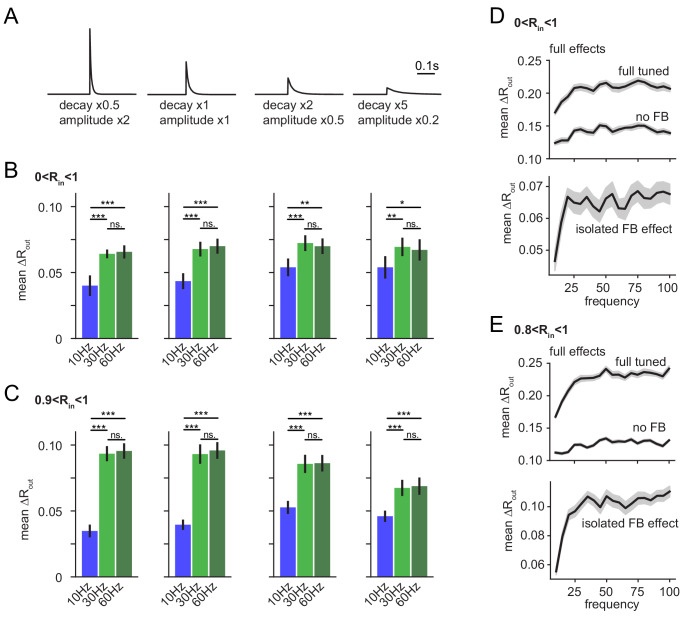
Robustness over various IPSC decay time-constants and over the full gamma range.(A–C) To test if the frequency dependence of feedback inhibitory pattern separation remained robust for different IPSC decay time constants we probed a range of altered time constants (our experimentally matched time constant x0.5, x1, x2 and x5) while maintaining total inhibitory conductance in the network constant by complementary adjustment of IPSC amplitude. As we expected a potential interaction between IPSC decay and modulation frequency, we probed model runs for each factor with 10 Hz, 30 Hz and 60 Hz modulation. The isolated feedback inhibitory effects were computed and impacts of decay and frequency were examined with 4 × 3 ANOVAs followed by Tukey posttests for differences between frequencies. Asterisks indicate significance in posttests given significant overall effects (*p<0.05,**p<0.01,***p<0.001). (A) Illustration of modified IPSC time-courses. (B) Mean pattern separation effect of isolated feedback inhibition over the full input similarity range (0 < Rin < 1). (C) Same as (B) but only for highly similar input patterns. Analyses in A-C were performed on seven new network seeds with simulation and analysis otherwise identical to Figure 6. (D–E) To probe the robustness of frequency-dependent feedback inhibitory pattern separation over an even larger range of frequency modulation, we next simulated the effects over a range from 10 to 100 Hz in 5 Hz steps. To provide computational tractability, we performed only eight runs per frequency (instead of 24 runs as in all other simulations) leading to fewer pattern comparisons, and somewhat noisier readouts. For the majority of frequencies, no input comparisons with R > 0.9 occurred so we defined (0.8 < Rin < 1) as highly similar input patterns, potentially leading to a slight underestimation of our effects.